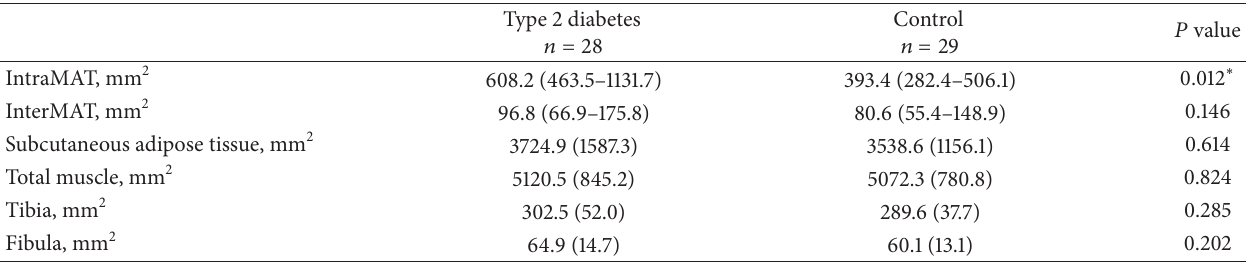
Table 2: Unadjusted comparison of cross-sectional area of lower leg compartments in women with and without type 2 diabetes.